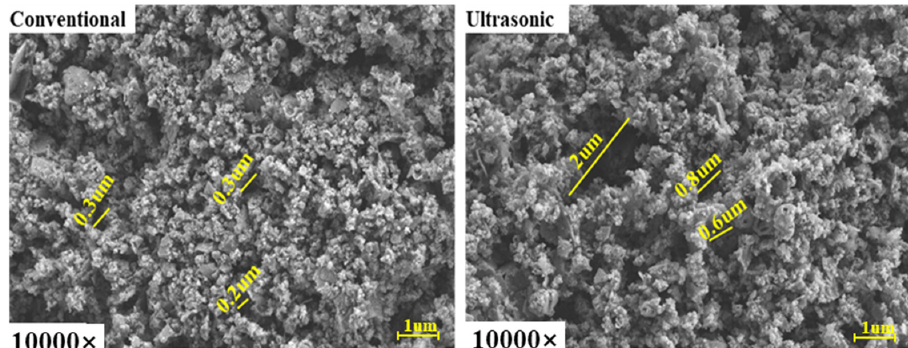
Figure 14. The SEM images of the leaching slag under traditional and ultrasonic